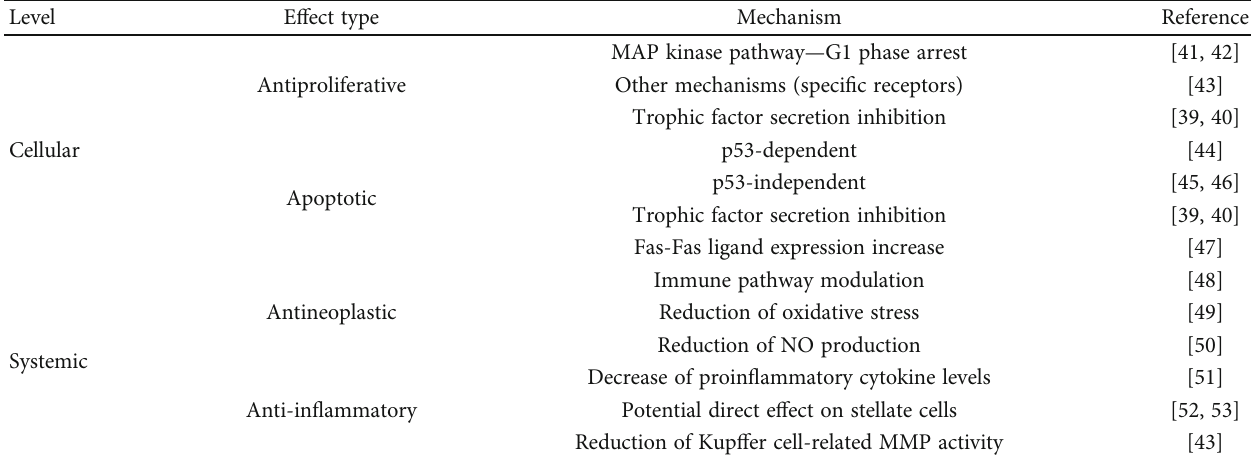
Table 1: Classi fi cation of therapeutic actions of somatostatin on